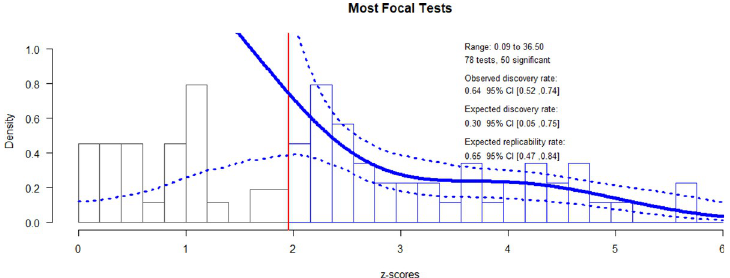
Fig 3. Z-curve of most focal hypothesis tests. The vertical red line refers to a z-score of 1.96, the critical value for statistical significance when using a two-tailed alpha of .05. The dark blue line is the density distribution for the inputted p -values (represented in the histogram as z-scores). The dotted lines represent the 95% confidence interval for the density distribution.